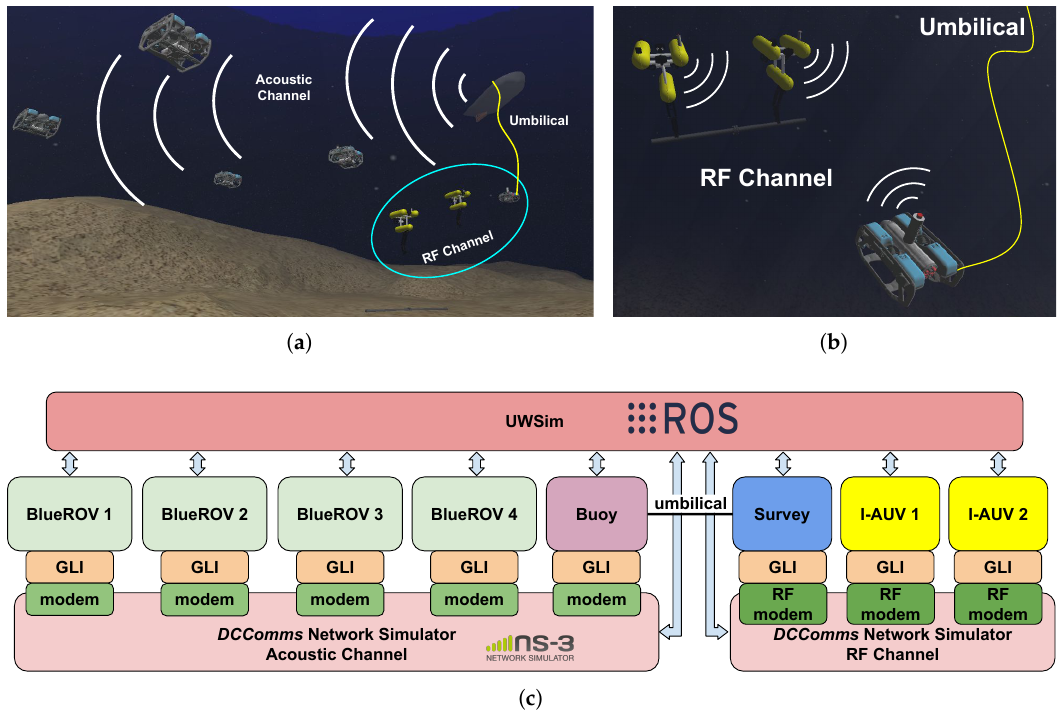
Figure 5. Illustration of the scenario of the second experiment. The four BlueROVs in charge of the visual surveying share the acoustic channel with the buoy on the surface. The communication between the two I-AUVs and the survey vehicle is based on an RF network: ( a ) general view of the scene; ( b ) details of the RF communication network between the two I-AUVs and the survey AUV with the umbilical to the surface; and ( c ) block diagram of the elements considered in this second experiment.